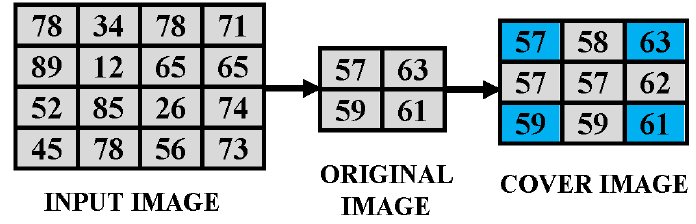
Figure 2. Explanation of the process of IP or scaling up of Image.